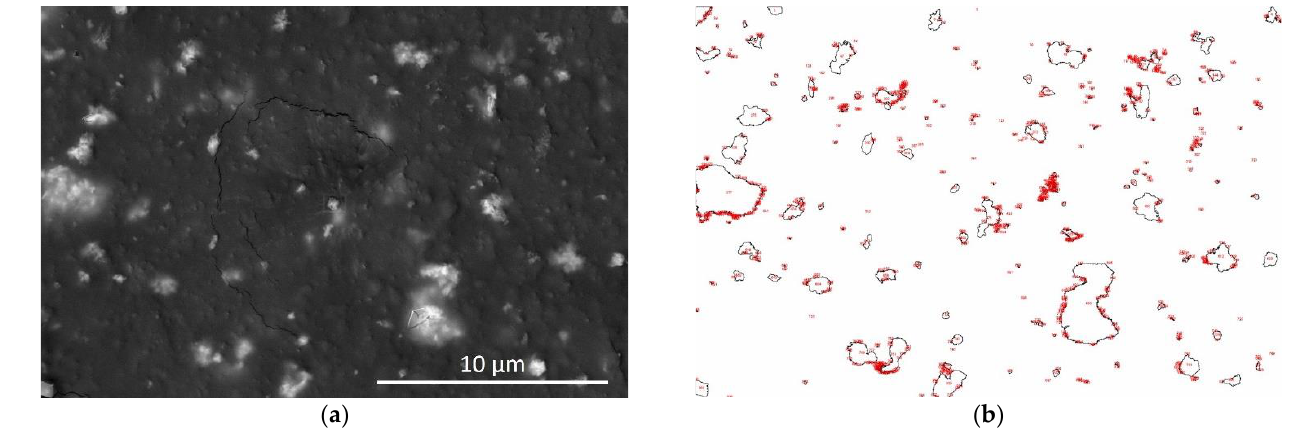
Figure 4. ( a ) SEM backscatter imagery of 2.5% ZnO sample. ( b ) Particle analysis using ImageJ demonstrating surface